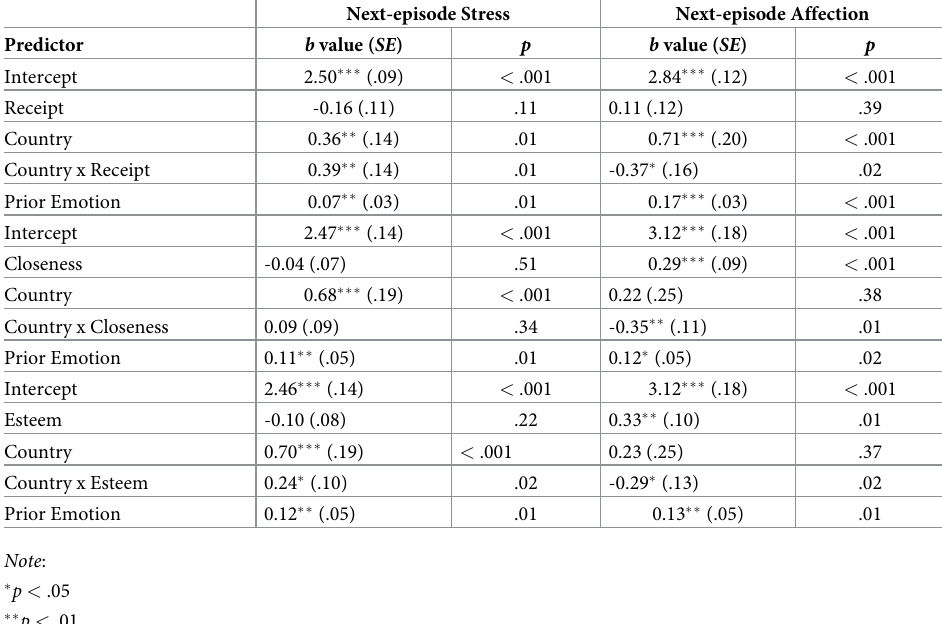
Table 1. Parameter estimates from multilevel regression models predicting next-episode stress and affection from previous emotion as a function of SS receipt and country. Next-episode Stress Next-episode